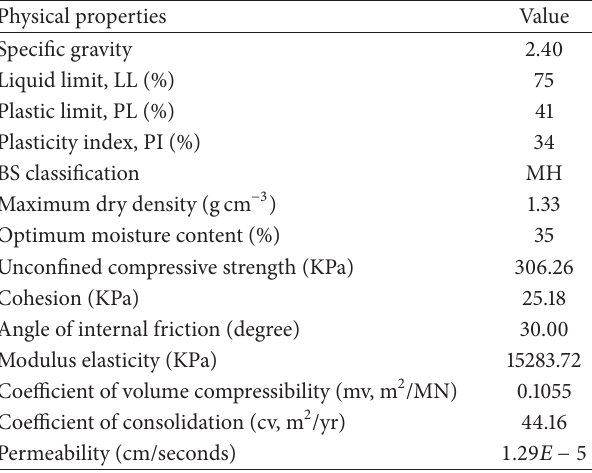
Table 1: Characteristics of the laterite soil.